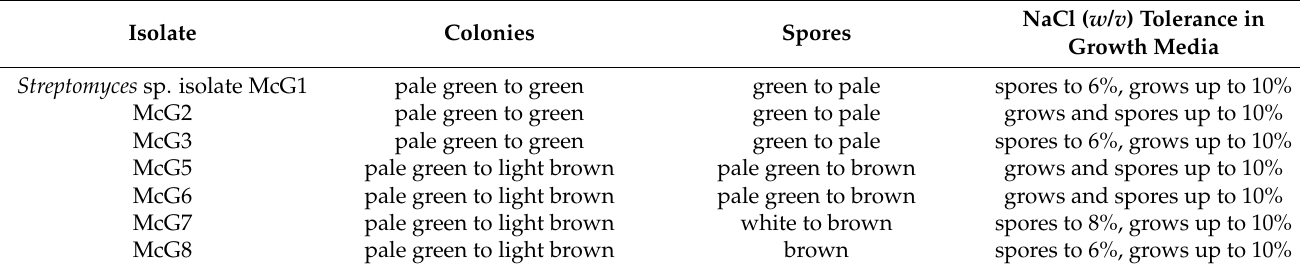
Table 1. Characterization of Streptomyces isolates from Boho, County Fermanagh. NaCl ( w / v ) Tolerance in Isolate Colonies Spores Growth Media Streptomyces sp. isolate McG1 pale green to green green to pale spores to 6%, grows up to 10% McG2 pale green to green green to pale grows and spores up to 10% McG3 pale green to green green to pale spores to 6%, grows up to 10% McG5 pale green to light brown pale green to brown grows and spores up to 10% McG6 pale green to light brown pale green to brown grows and spores up to 10% McG7 pale green to light brown white to brown spores to 8%, grows up to 10% McG8 pale green to light brown brown spores to 6%, grows up to 10% Microscopically, all Streptomyces isolates were Gram-positive, filamentous, with